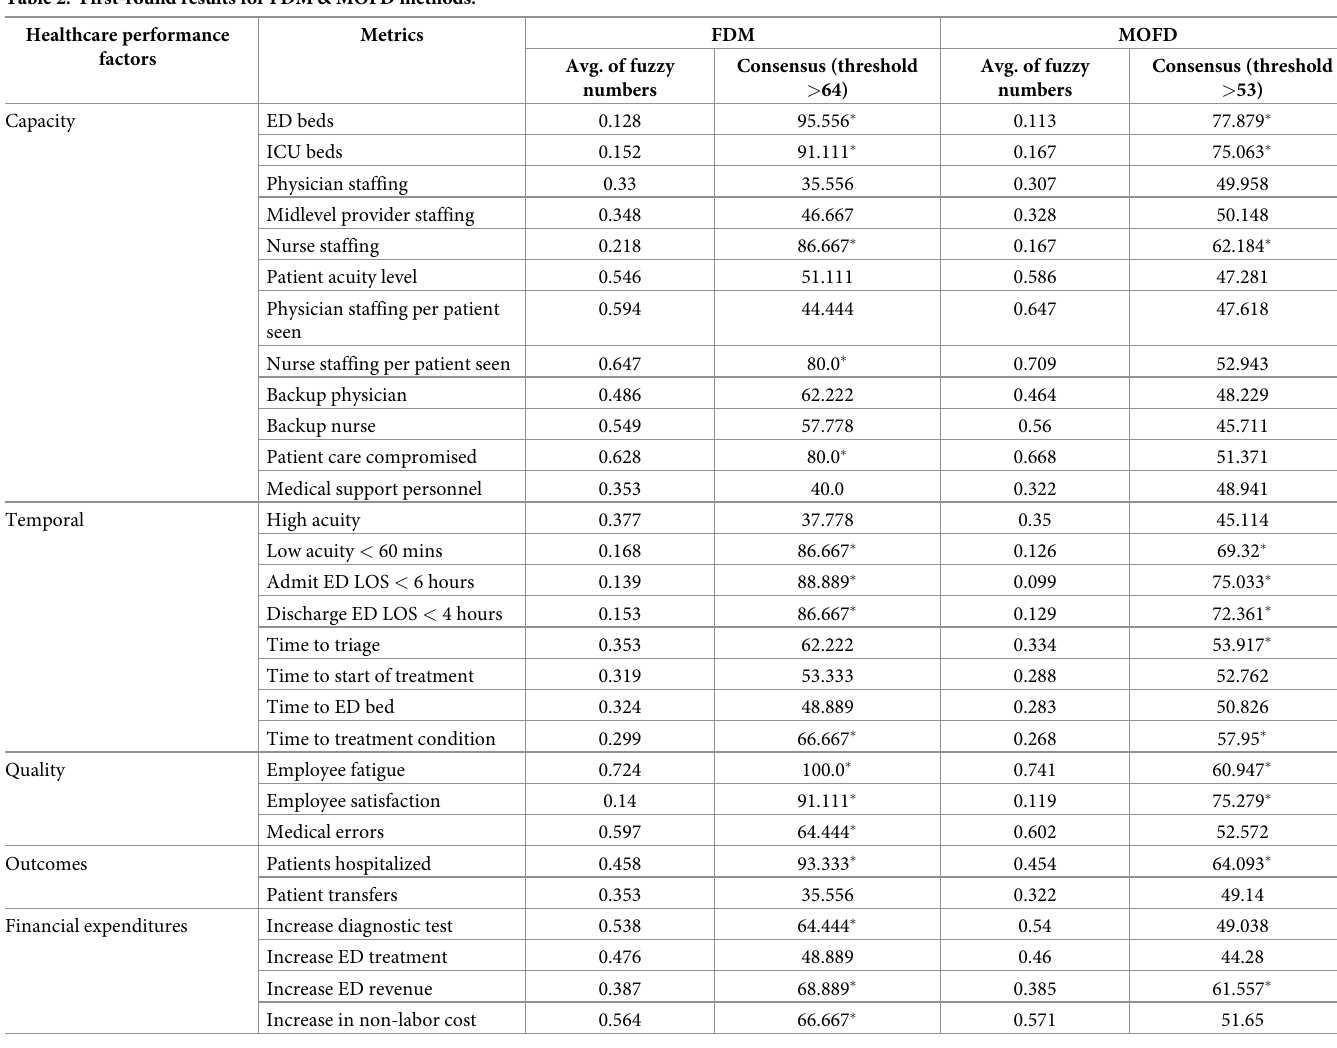
Table 2. First-round results for FDM & MOFD methods.